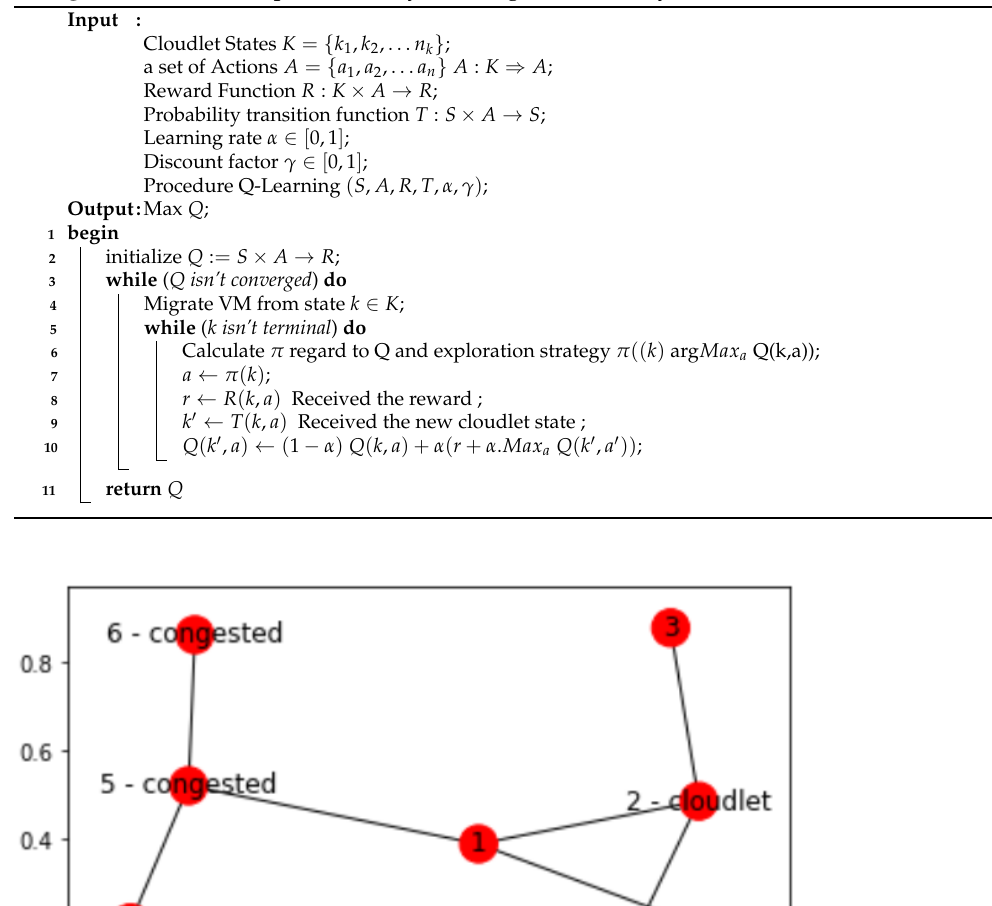
Algorithm 5: E-Transport Mobility and Migration latency.